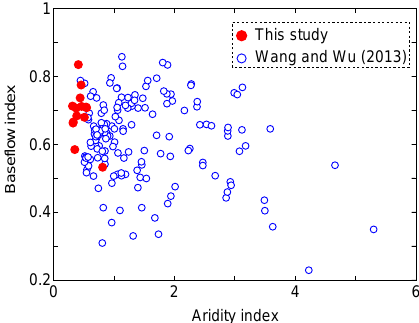
Figure 16. Perennial stream density and baseflow coefficient ( Q b /P ). The baseflow, Q b , in their study was estimated by us- ing the same equation and parameter value as we used in Eq. (3). The correlation efficient between them was 0.74 without the study catchments (Wang and Wu, 2013) and 0.72 for the entire data